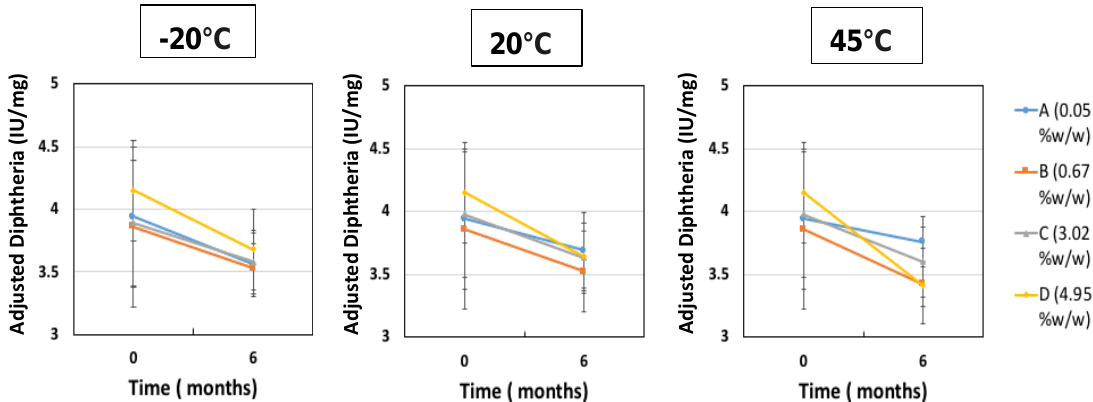
Figure 6. Change in monomer (%) after 6 months of storage at 45 °C for different initial moisture samples of IgG 50 mg/mL (A = 0.05% ± 0.01% w/w, B = 0.67% ± 0.14% w/w, C = 3.02% ± 0.06% w/w and D = 4.95% ± 0.40% w/w ). Monomer content was stable for − 20 and 20 °C at 84.0% ± 0.5% Error bars represent 95% confidence intervals ( n = 3 vial replicates).